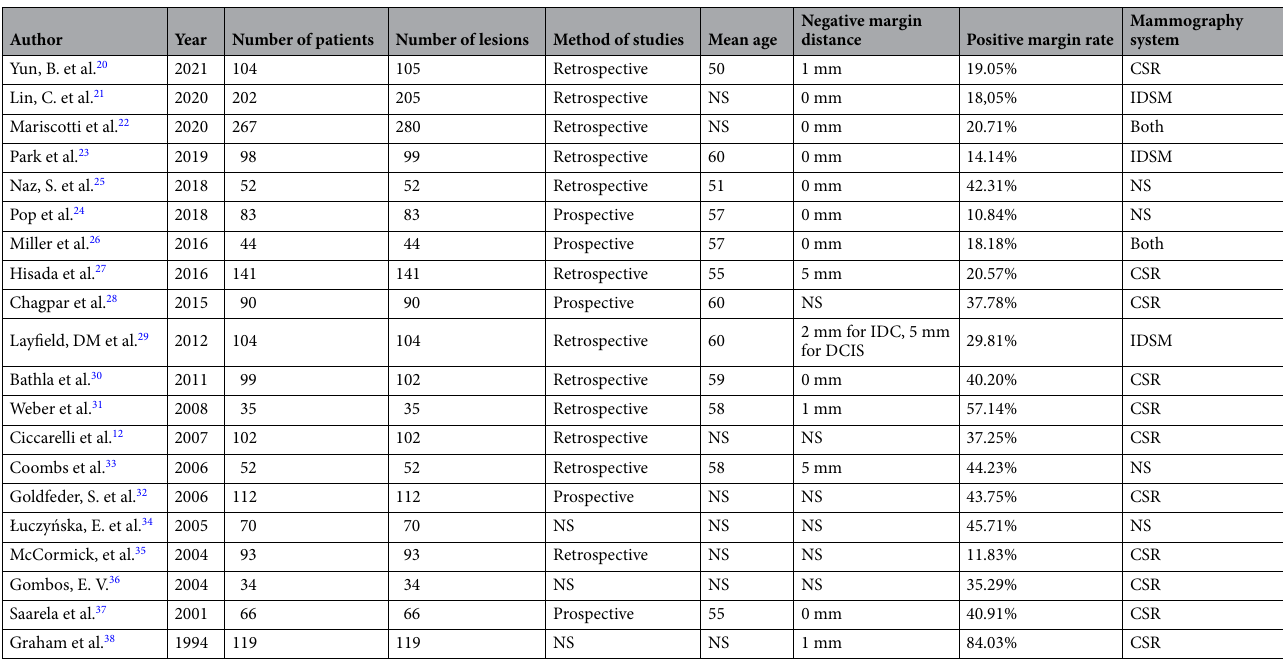
Table 1. Principal characteristics of the included studies. NS not shown; IDC invasive ductal carcinoma; DCIS ductal carcinoma in situ; IDSM intraoperative digital specimen mammography; CSR conventional specimen radiography.